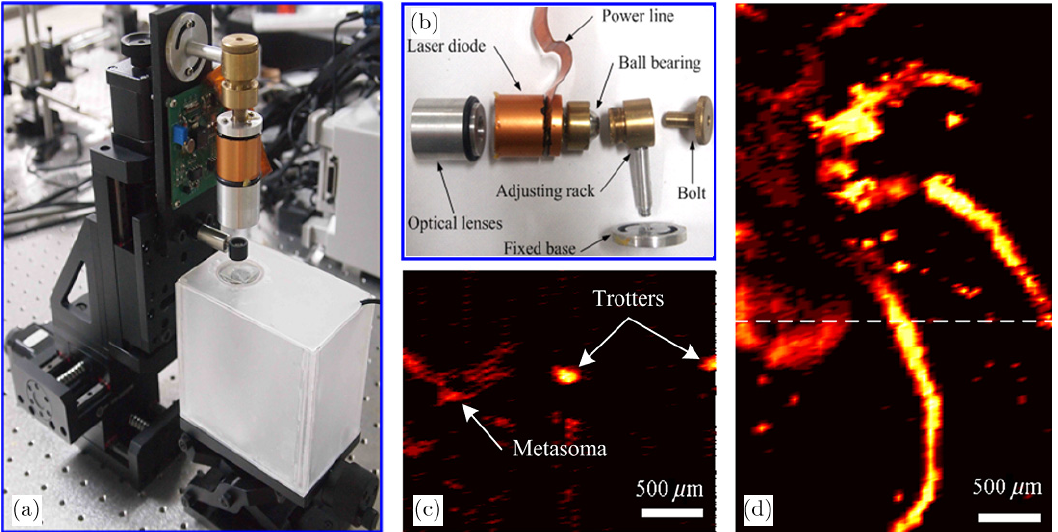
Fig. 5. (a) and (b) Photograph of pulsed NIR LD-PAM system and its laser diode excitation and (c) and (d) photoacoustic images of the ant along the depth and horizontal directions (images adapted from Refs. 83,